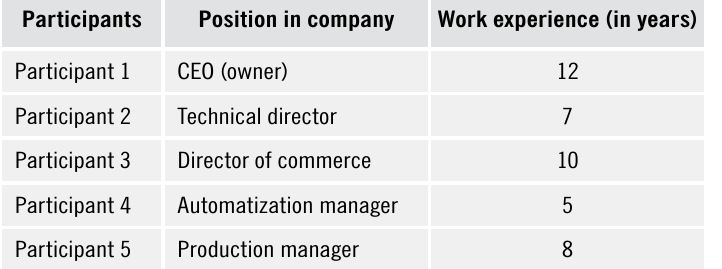
Table 2. Profile of focus group discussion